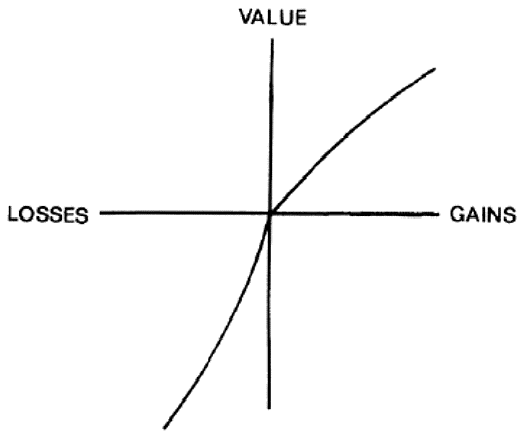
Figure 2. Hypothetical Value Function S curve [52]